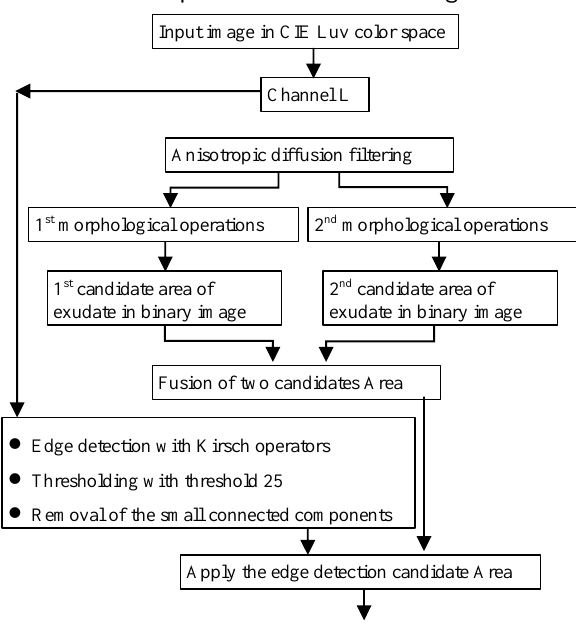
Figure 3. Block diagram of the first step of detection .